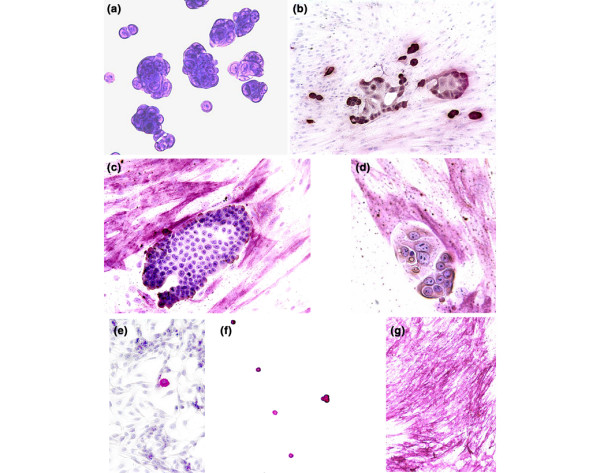
Microscopic appearance of tumor cells and fibroblasts. (a) Numerous clumps of UACC-812 tumor cells resembling abortive mammary glands are evident. (b) UACC-812 breast cancer cells seeded at low density on a monolayer of serum-activated fibroblasts. Note the gland formation and the invasive infiltration by tumor cells into fibroblasts. Primary tumor cells derived from (c) human ductal carcinoma in situ and from (d) invasive ductal carcinoma co-cultured with fibroblasts yielded clonogenic growth next to myofibroblasts that expressed α-smooth muscle actin (pink immunostain). Breast cancer cells grown (e) on a monolayer of B16 cells or (f) without a monolayer of fibroblasts generally grew as individual cells identifiable by their red staining for epithelial membrane antigen. (g) Serum-activated fibroblasts also uniformly expressed abundant syndecan-1, as detected by immunocytochemical staining.